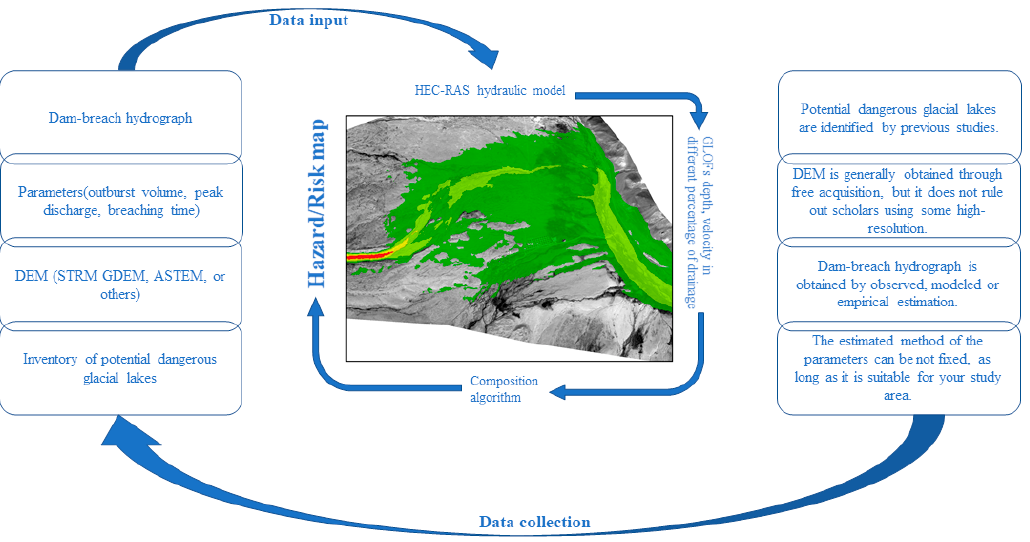
Figure 10. A paradigm for mapping GLOF hazard/risk.